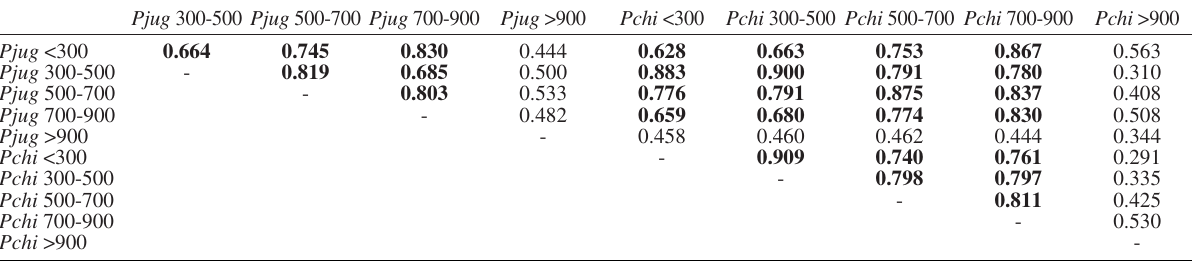
Table 6. – Schoener’s dietary niche overlap index among species ( Pjug, Prolatilus jugularis ; Pchi, Pinguipes chilensis ) and upper jaw length ranges (<300, 300-500, 500-700, 700-900 and >900 μm). Bold numbers indicate biologically relevant niche